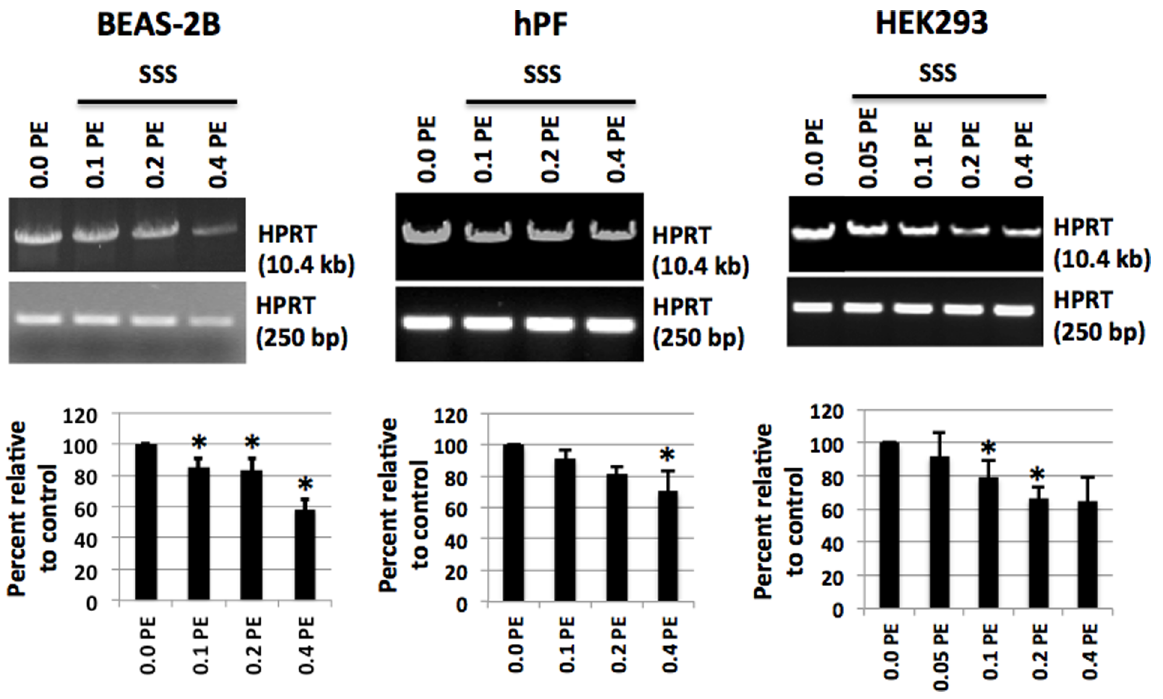
Figure 3. Increased oxidative DNA damage in various human cells. Following exposure to a series of dilutions of SSS–laden DMEM for 24 h, DNA isolation and digestion with Fpg and Nei followed by qPCR for amplification of HPRT large and a short fragment (LA-QPCR assay). Three cell lines, HEK293, hPF and BEAS-2B, all exhibited a dose-response relationship between levels of oxidative DNA damage and the SSS doses used in the LA- QPCR assay. PE: puff equivalents (the smoke from one puff in 1 ml of medium).